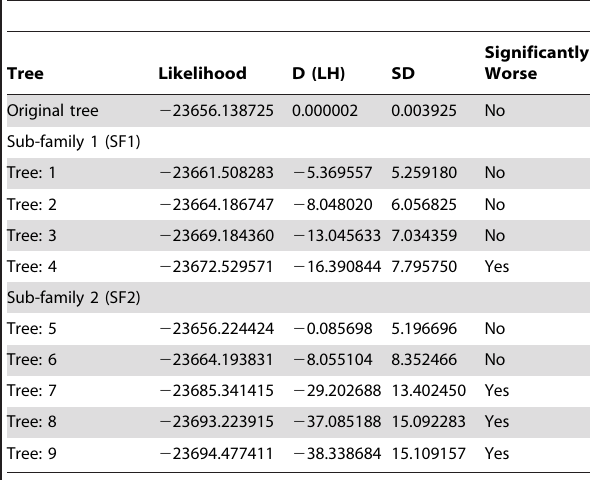
Table 2. Results of the SH test of phylogenetic trees for GHF5